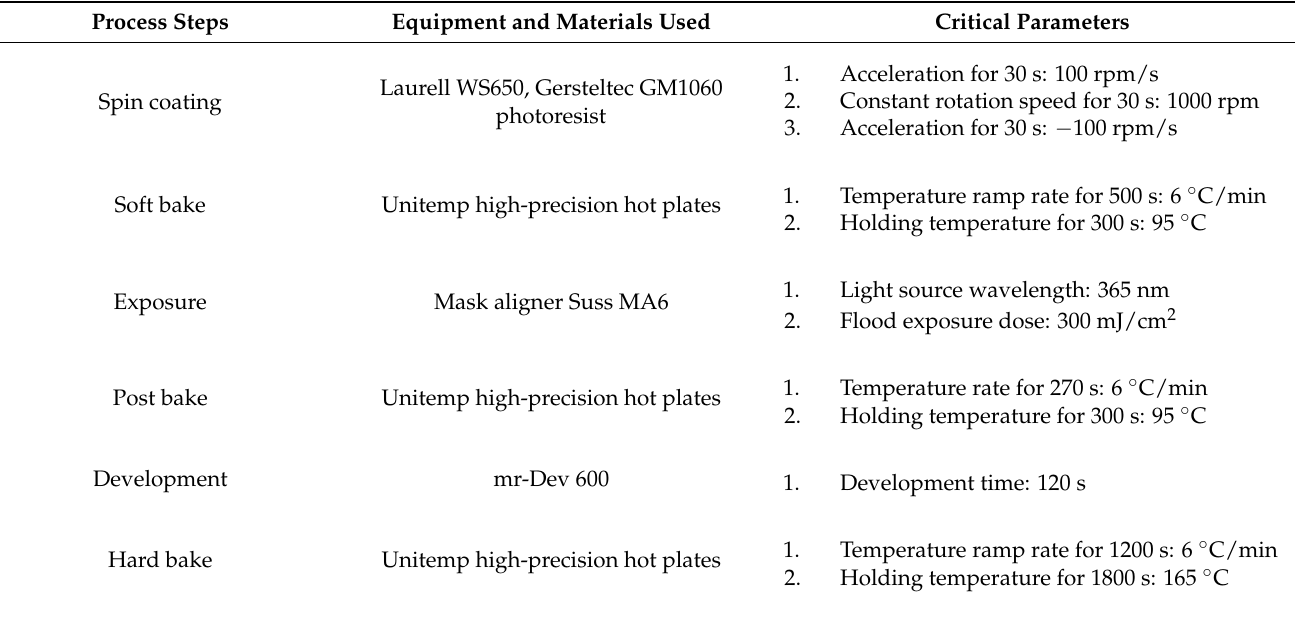
Table 1. SU-8 thin film